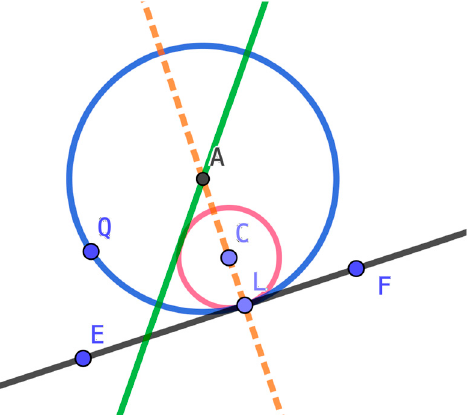
Figure 4. The intersection of the perpendicular bisector of QL and the perpendicular to EF at L is the center of the tangency circle to L that passes through point Q.